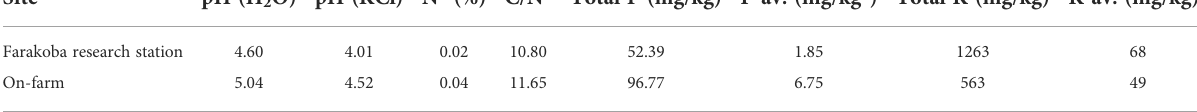
TABLE 1 Average soil chemical characteristics for two sites in Burkina Faso.